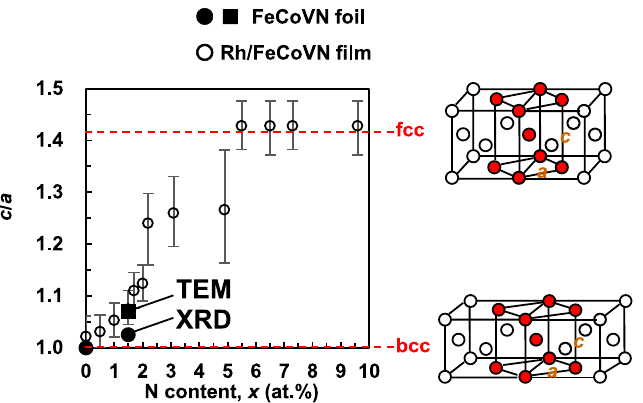
Figure 6. x -dependences of c / a for (Fe 0.45 Co 0.45 V 0.10 ) 100− x N x foils with x = 0 (as-rolled) and 1.5 (nitrided at T = 650 °C), and